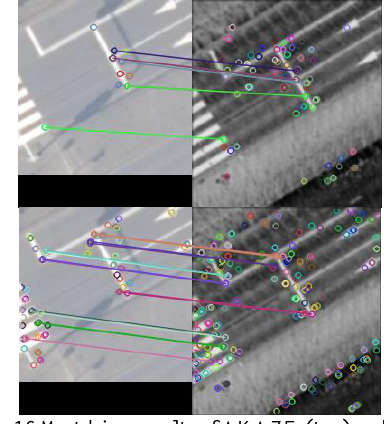
Figure 16 Matching results of AKAZE (top) and KAZE (bottom) in 4 th run on scene 2.